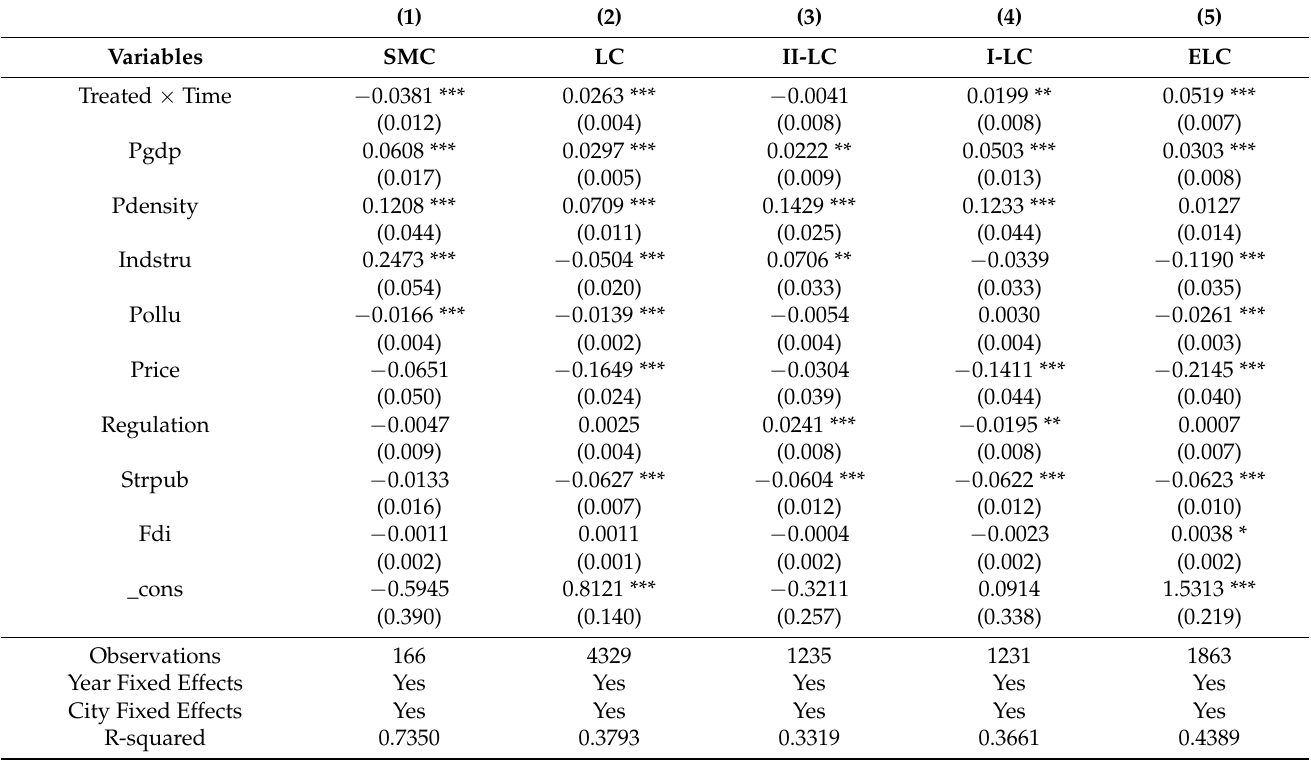
Table 7. Heterogeneity test: city